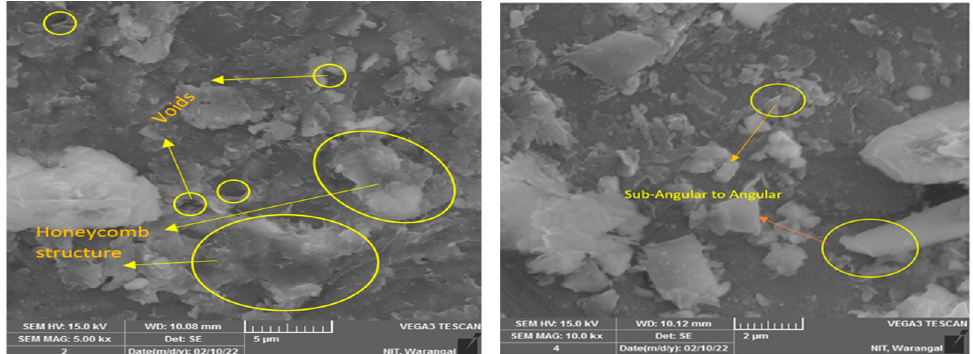
Figure 1. SEM images of clay and granite sand used in the